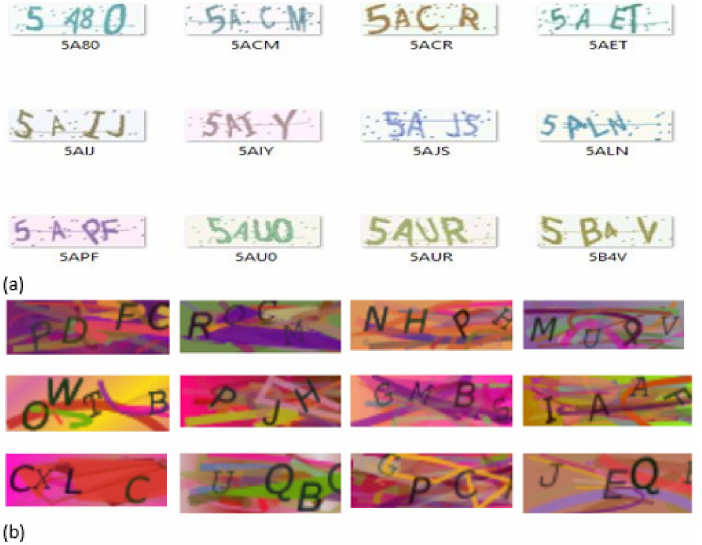
Figure 2. ( a ) Sample of the generated text-based CAPTCHAs with conventional noise using an open source Python library; ( b ) Sample of collected complex real world text-based CAPTCHA images.